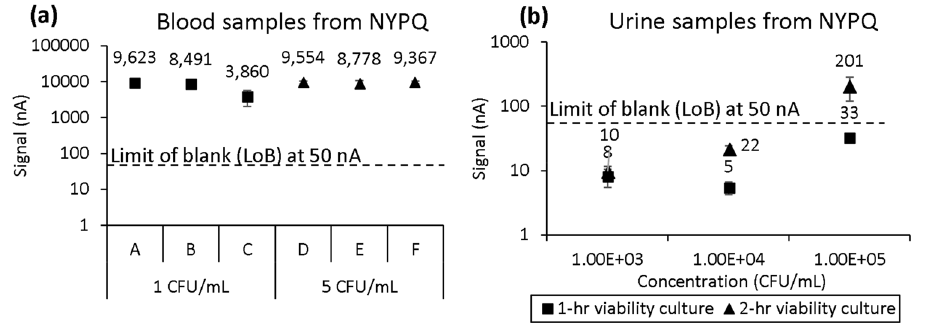
Figure 6. Feasibility study of specimen transportation of contrived ( a ) blood and ( b ) urine samples shipped from NYPQ to GeneFluidics through FedEx Clinical Pak overnight express. Each error bar represents 5 data